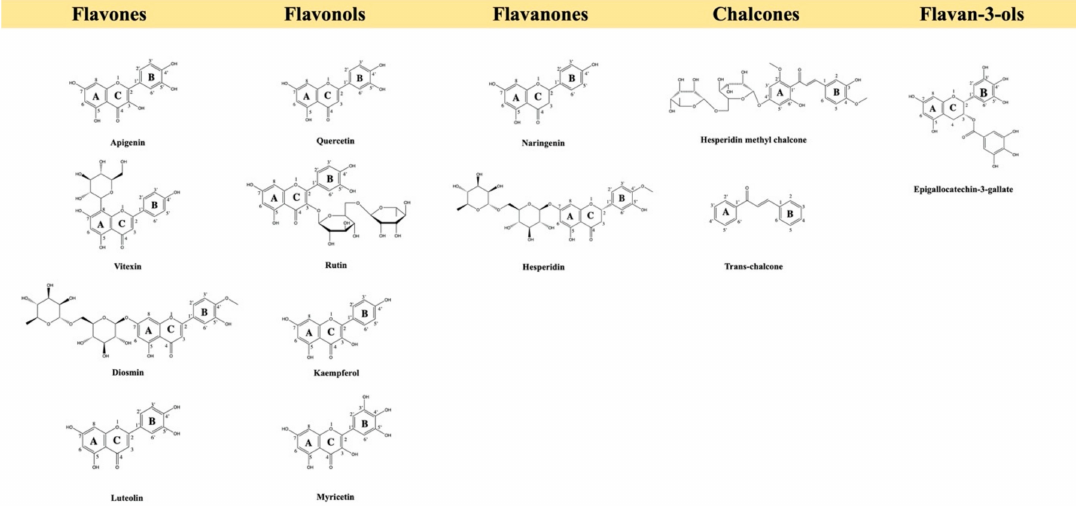
Figure 5. The chemical structures of the flavonoids discussed in this